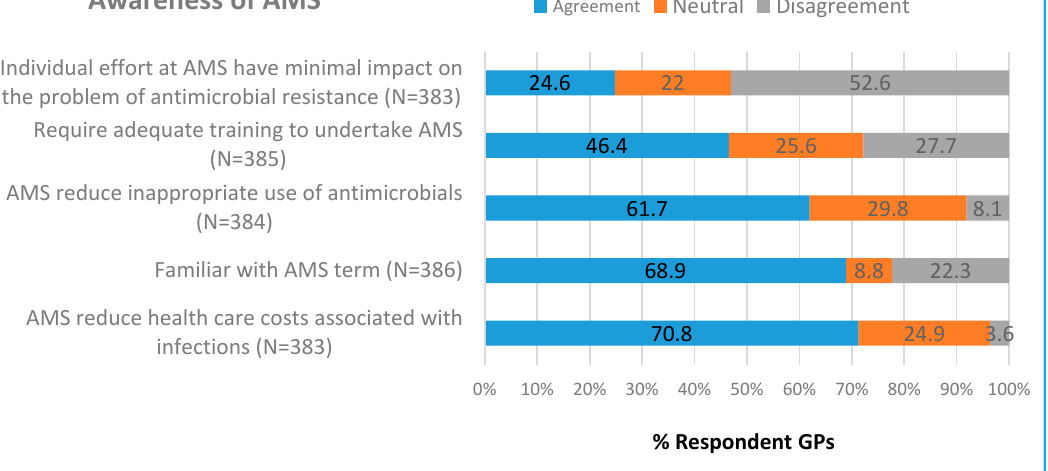
Figure 1. Proportion of GPs agreeing with the objectives and awareness of antimicrobial stewardship (AMS).